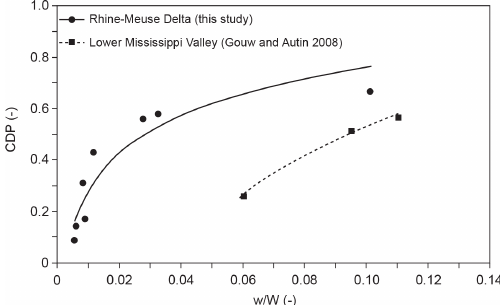
Figure 12. Channel-belt deposit proportion (CDP) plotted against normalized channel-belt sand body width ( w/W ), the Rhine–Meuse delta (points) and the Lower Mississippi River valley (rectangles). The data reveals a positive relationship between the two variables. The Rhine–Meuse data clearly displays a strong increase of CDP with w/W when w/W is low ( < 0.02). The sensitivity of CDP for changes in w/W declines with increasing w/W . Data for the Lower Mississippi River valley are from Gouw and Autin